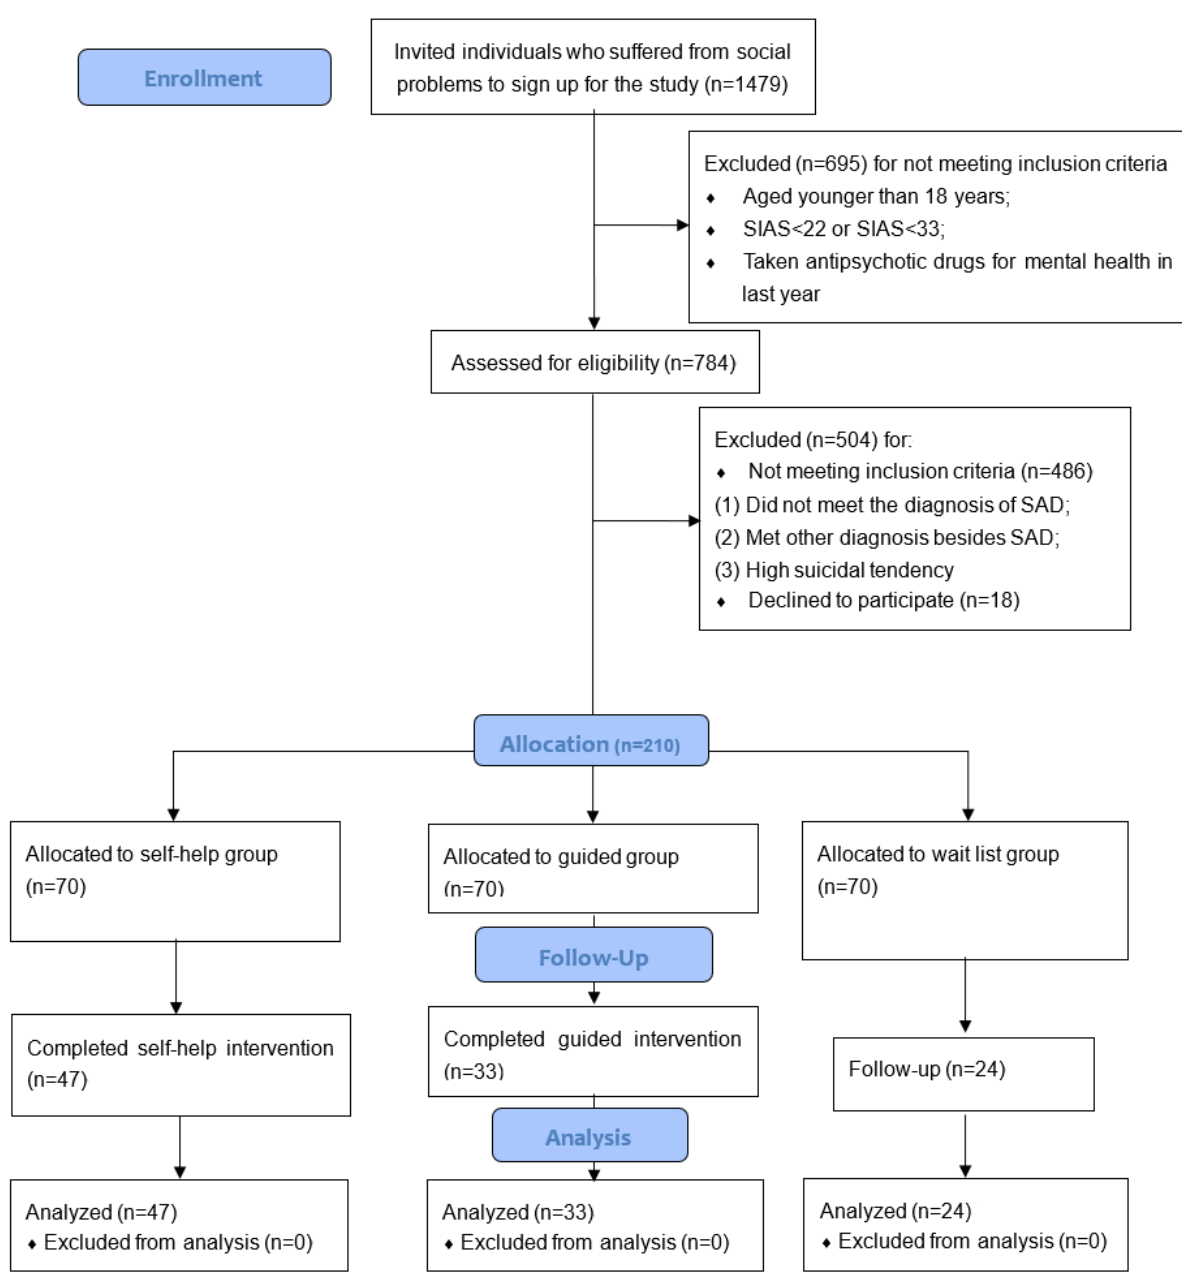
Figure 1. Flowchart of this